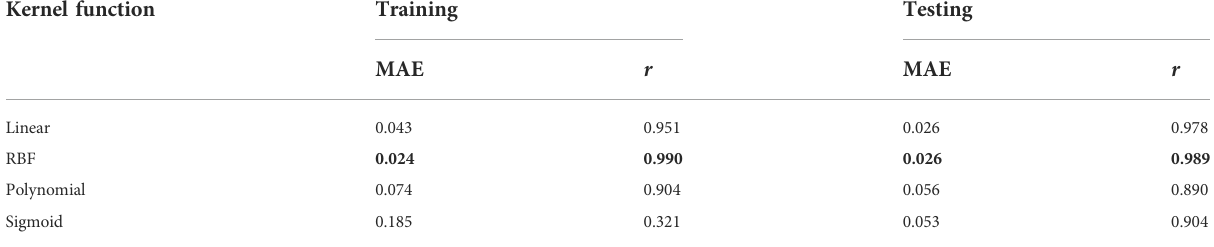
TABLE 5 Performance of RBF kernel functions.